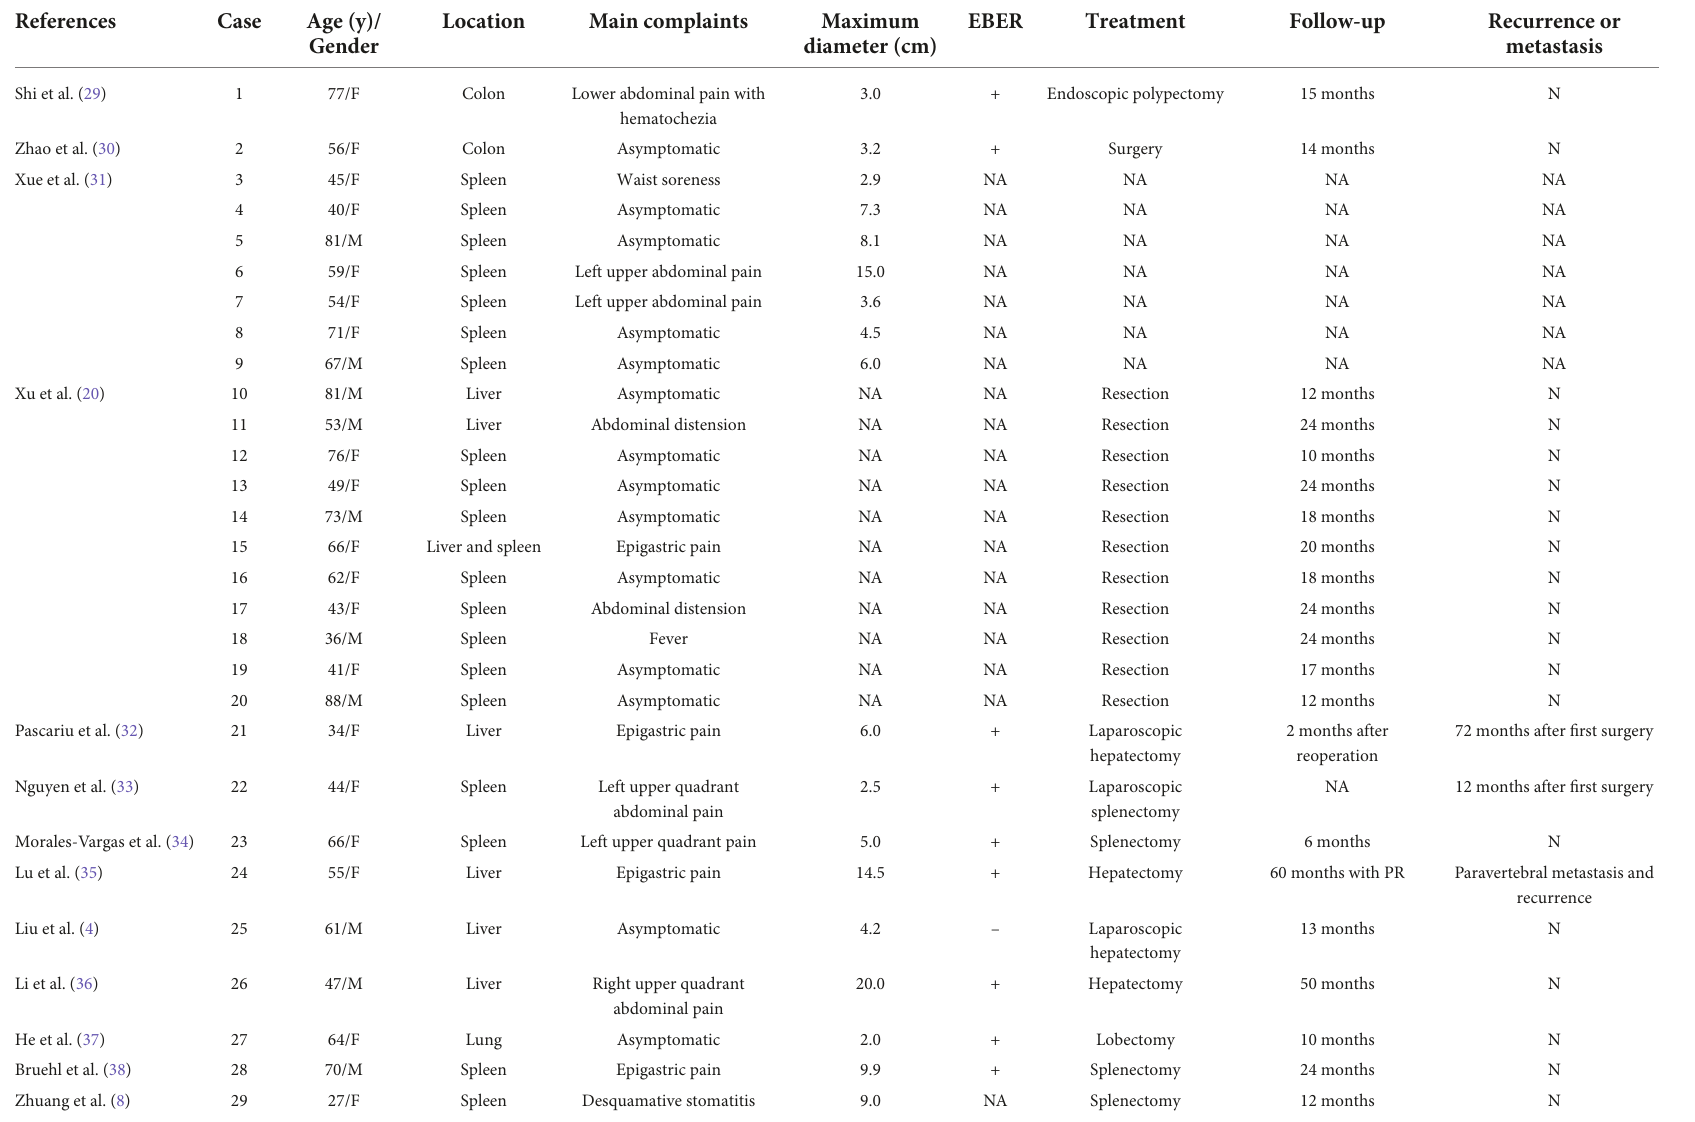
TABLE 1 Clinical characteristics of patients with inflammatory pseudotumor-like follicular dendritic cell